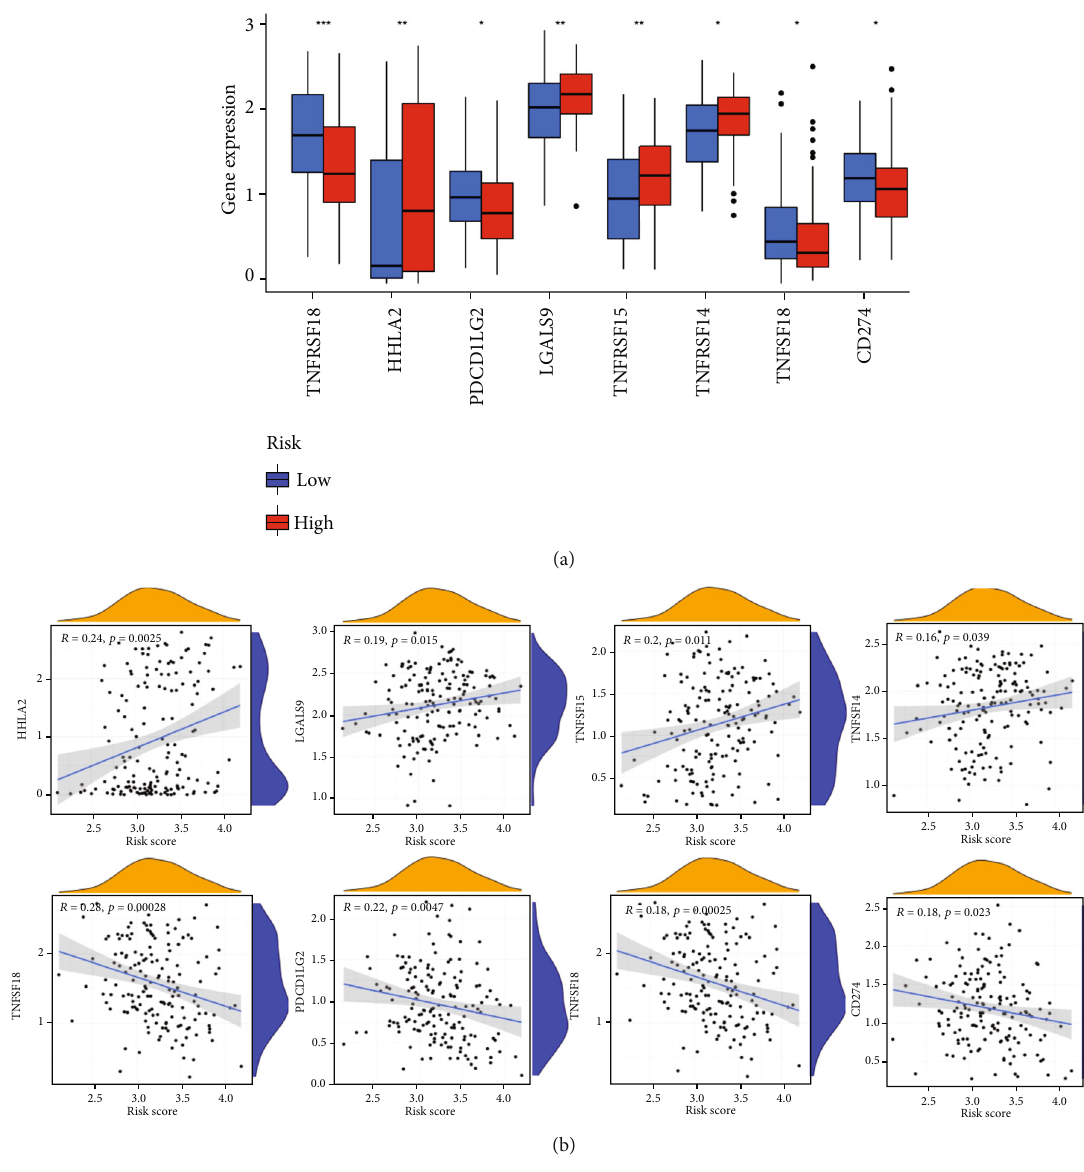
Figure 5: Relationship between MAIP1 and immune checkpoint-related genes. (a) Expression of 8 immune checkpoint-related genes in MAIP1 high and MAIP1 low groups. (b) Scatter plots show the signi fi cant correlation between MAIP1 and the eight immune checkpoint- related